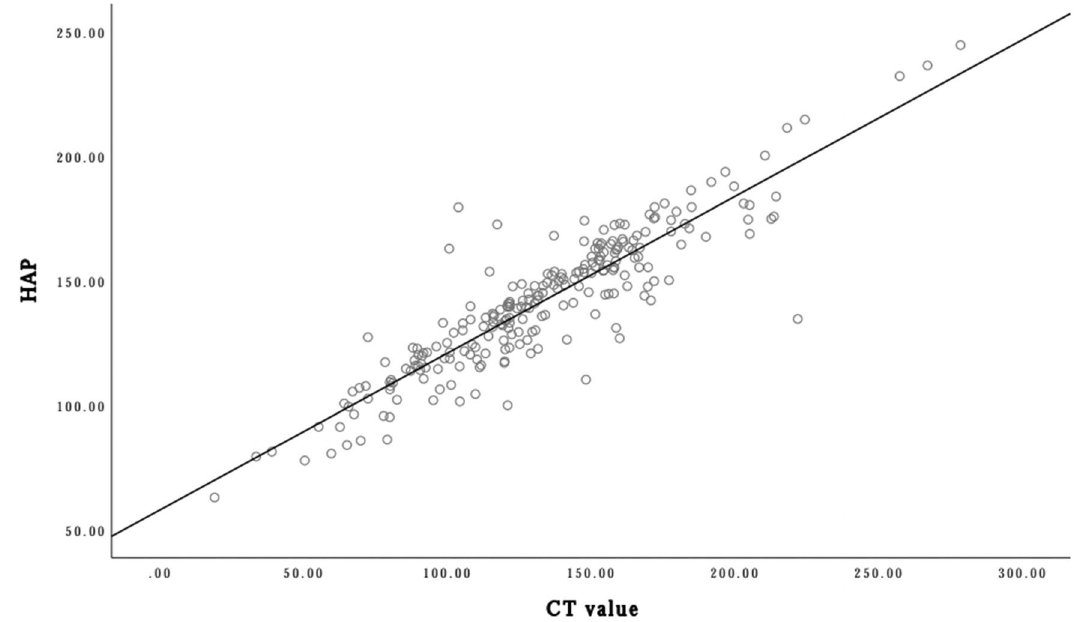
Figure 4. Scatter plots of CT value and HAP. There was a linear correlation between CT value and HAP. And the linear regression equation was: HAP = 57.941 + 0.629 × CTvalue (black slant